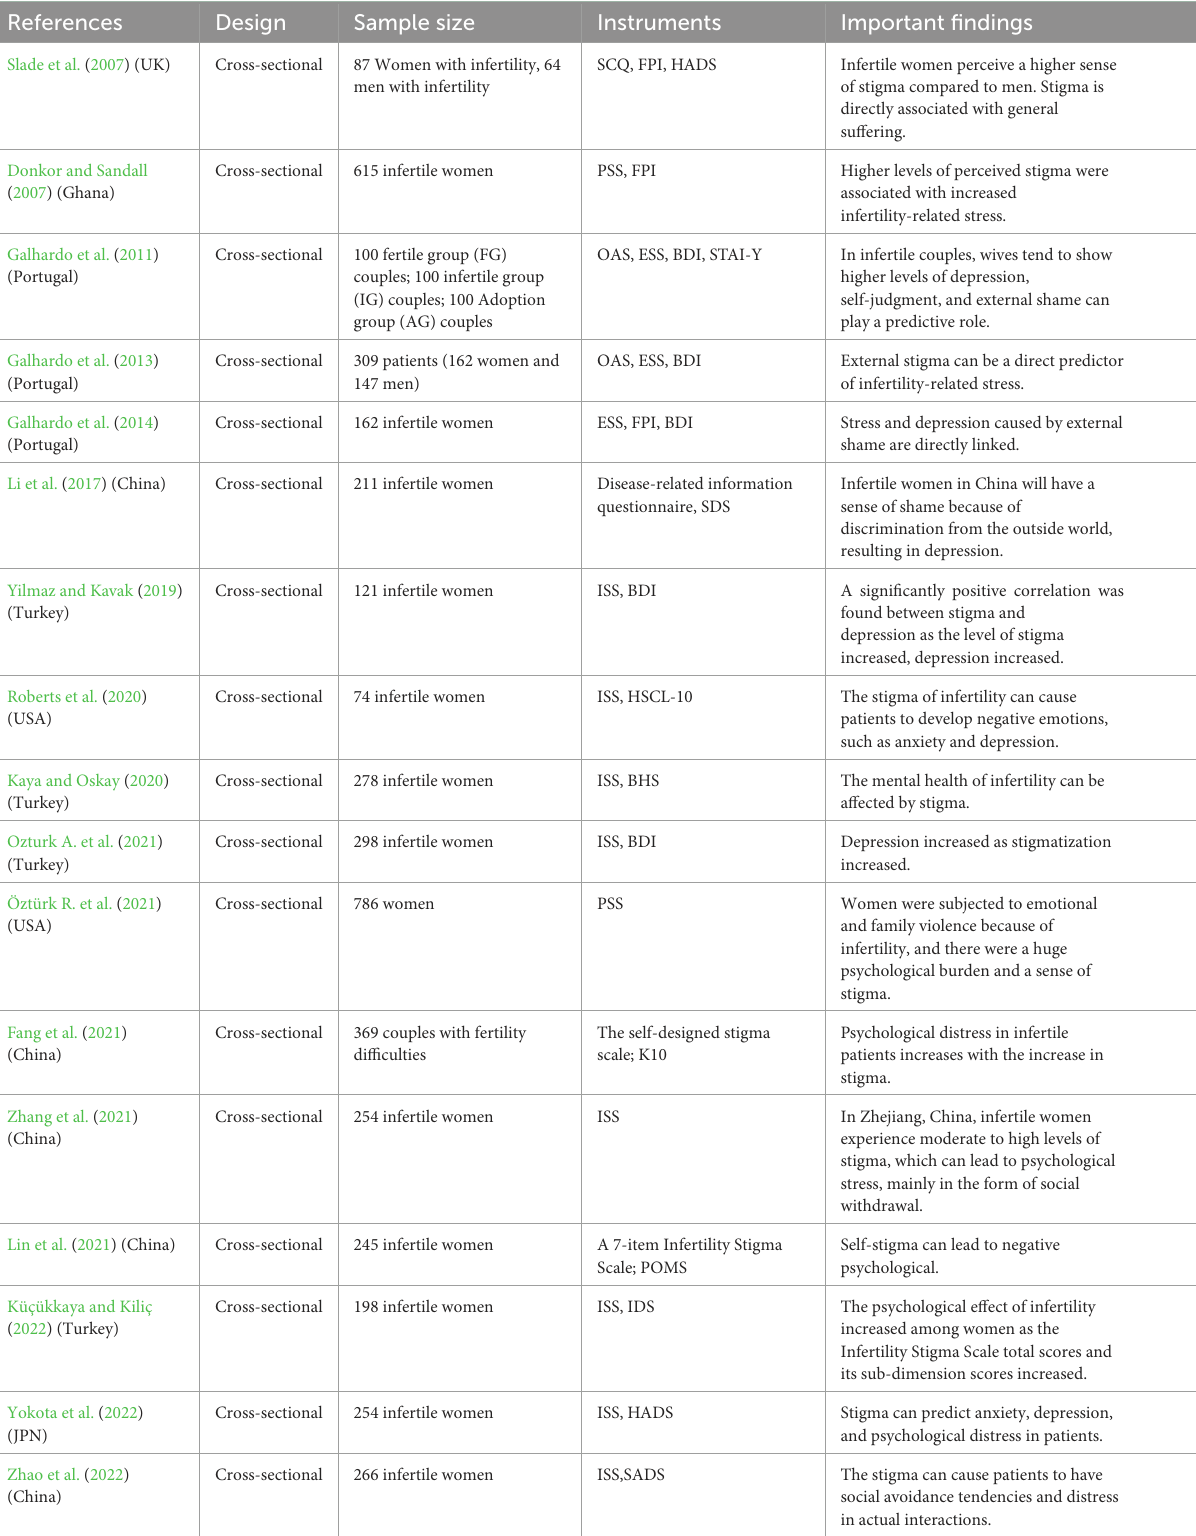
TABLE 2 Summary of the effects of disease stigma on mental health in female patients with